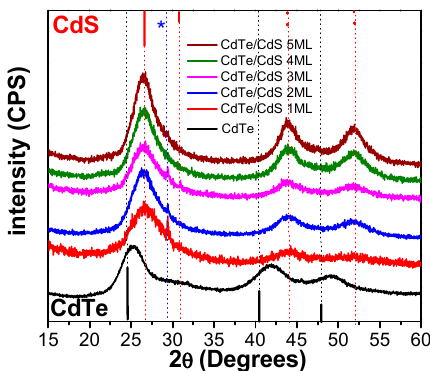
Figure 3. X-ray diffraction patterns of CdTe core and CdTe/CdS core/shell quantum dots (QDs) with different numbers of layers (one to five) of CdS. * Impurities or byproducts not identified in the JCPDS data base.